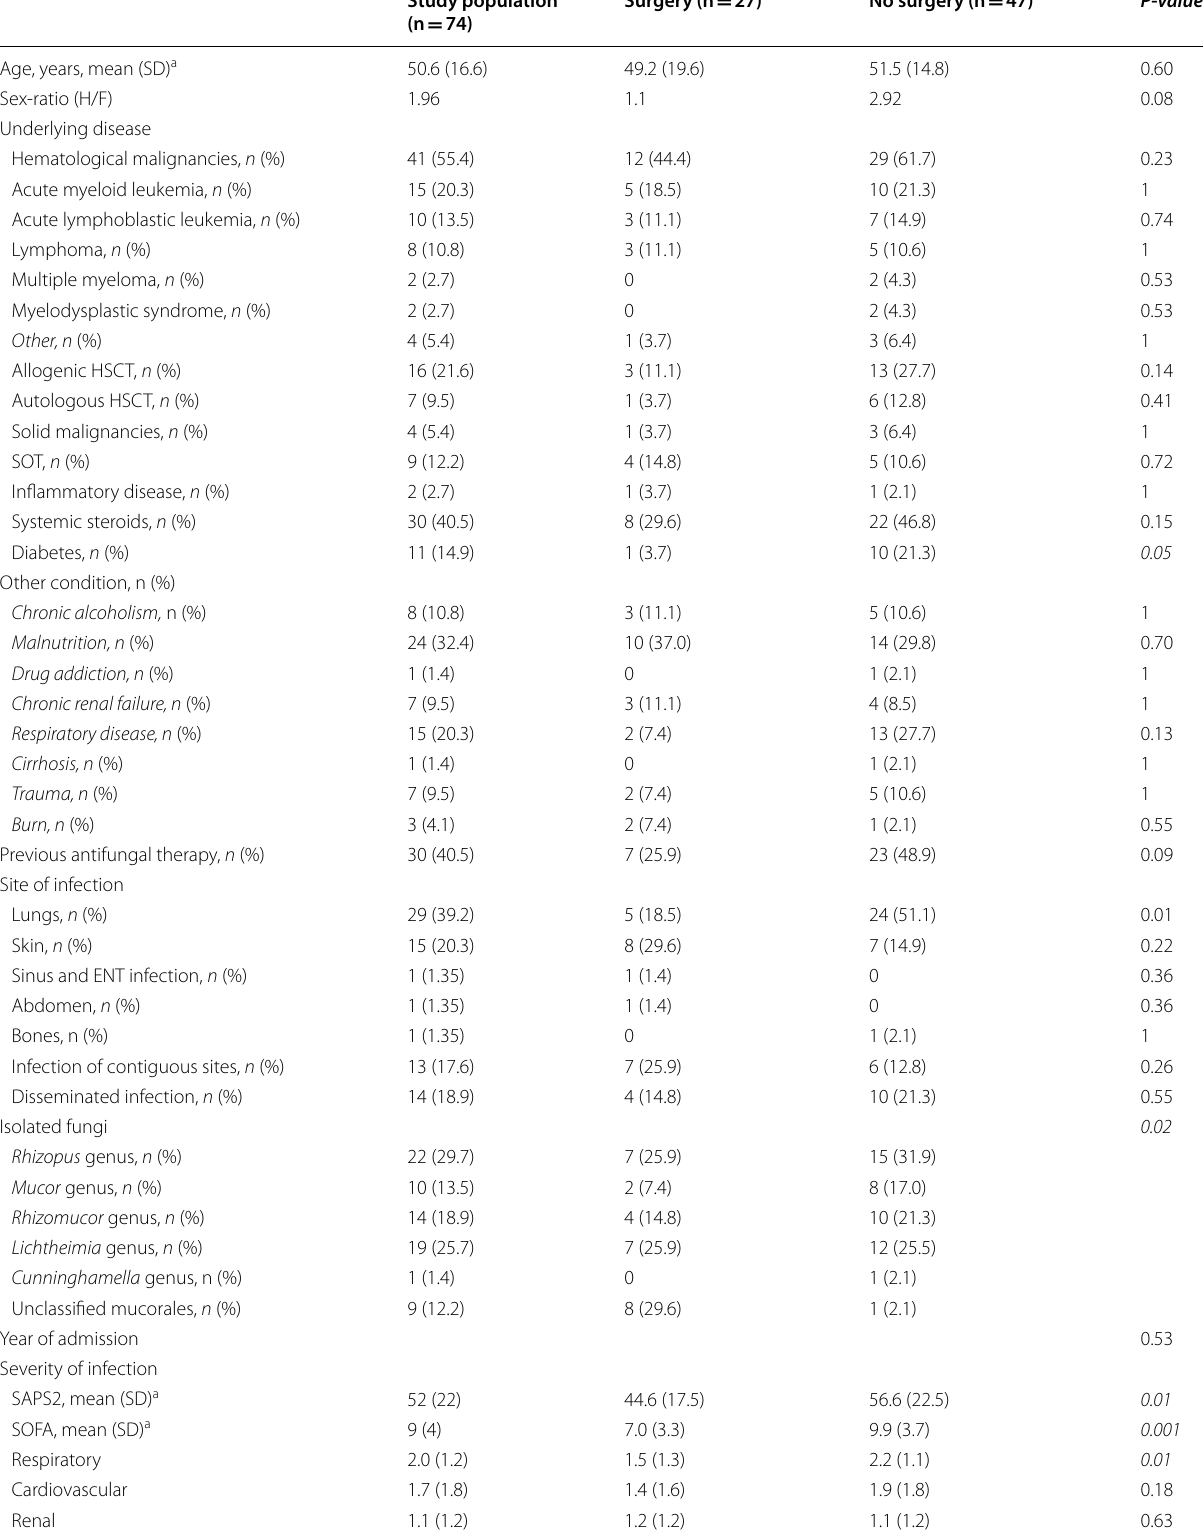
Table 3 Comparison of the 74 mucormycosis according to the surgical status